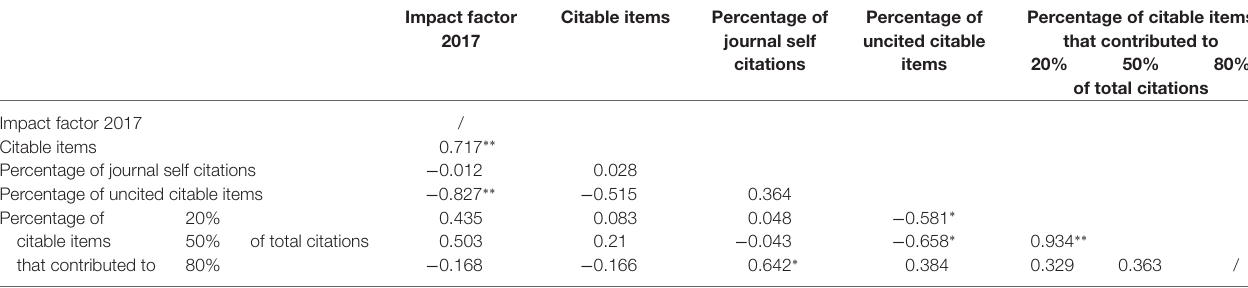
TABLE 2 | Pearson correlation coefficients between various citation parameters of neuroimaging